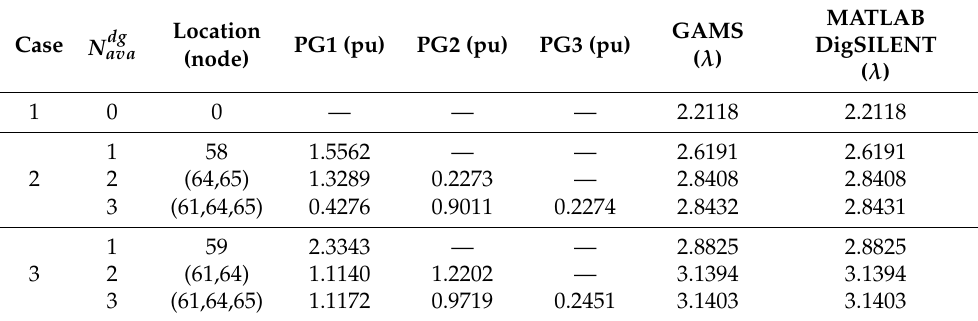
Table 5. Numerical performance of the λ -coefficient in the IEEE 69-bus system for all the simula- tion cases.